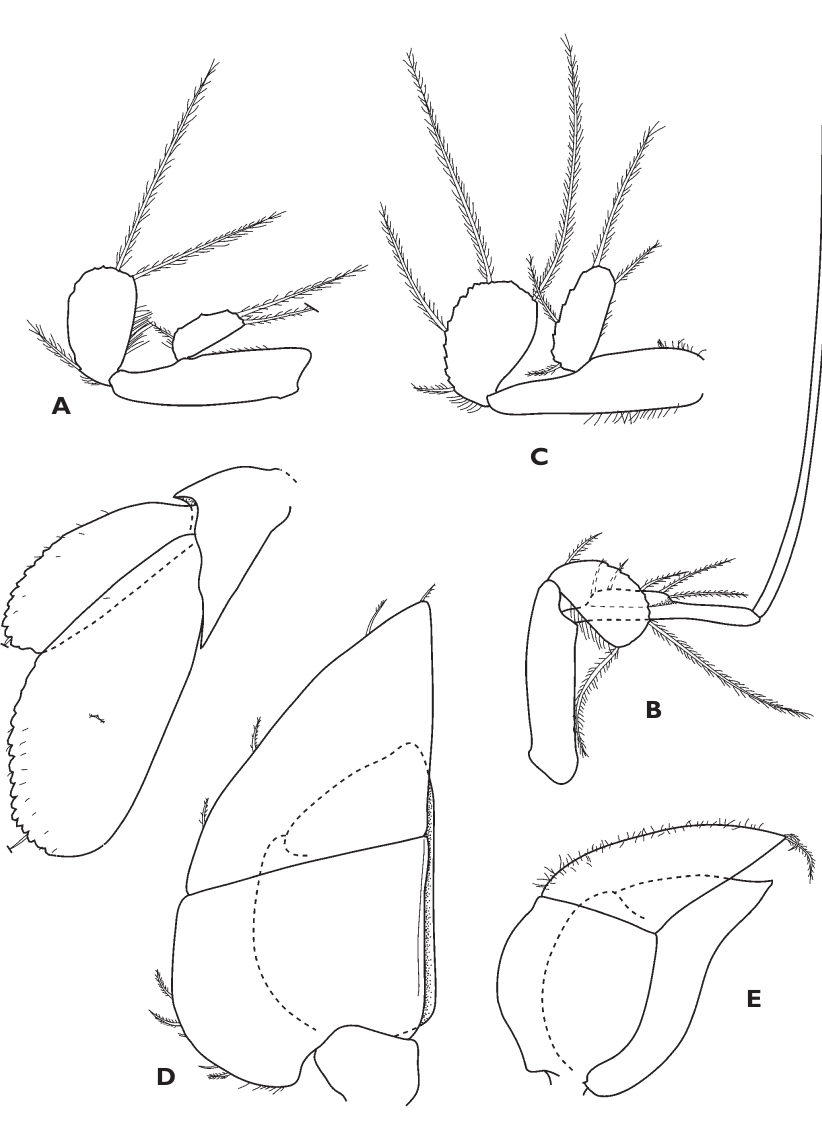
Figure 8. Sedorolis simplex sp. n. Paratype ♂ 4.8 mm, Is.6001. A–E pleopods 1–5 respectively F uropods.